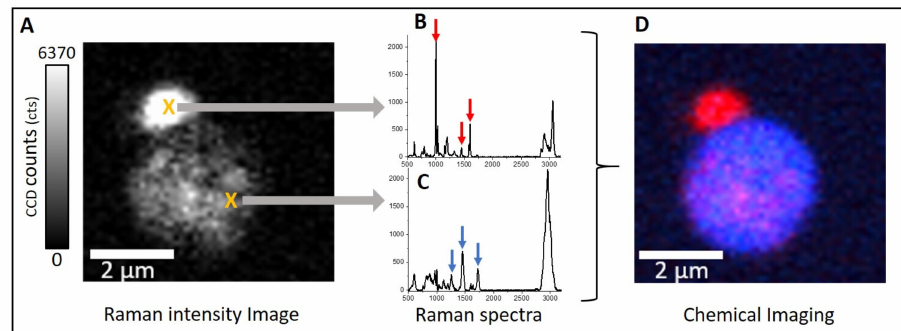
Figure 3. ( A ) Raman intensity image of a particle S3 . ( B , C ) Raman spectra recorded in the range from 500 to 3200 cm − 1 at the locations marked with X. Characteristic Raman signals are marked with red and blue arrows (see text for details). ( D ) The Raman image is based on the assignment of spectra in each pixel. Pixels dominated by spectrum ( B , C ) are color-coded with red and blue,